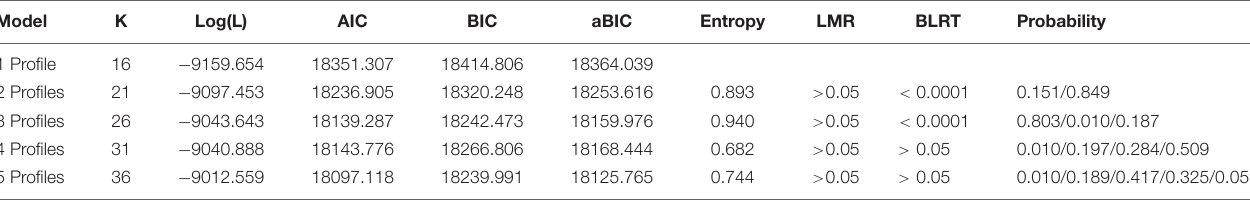
TABLE 3 | Fit indexes of LGMMs for the negative affect.